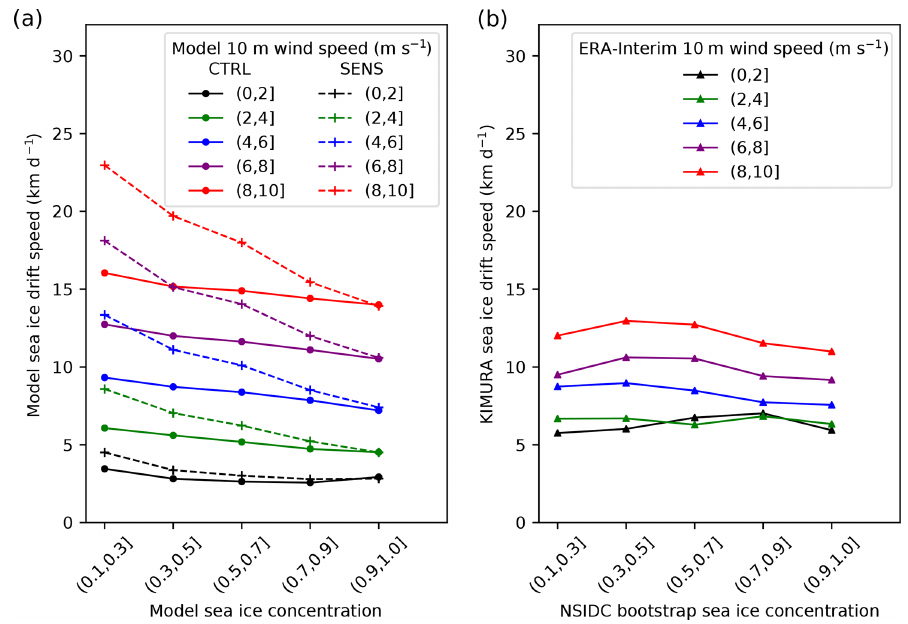
Figure 10. The (a) simulated relationship between sea ice drift speed and sea ice concentration for different near-surface wind speed classes (different colors) for the 2007 summer (JJAS) in the CTRL (circle marker and solid line) and SENS (cross marker and dashed line) experi- ment. The relationship based on KIMURA sea ice drift speed, NSIDC bootstrap sea ice concentration, and ERA-Interim 10m wind speed is shown in (b) . The points in the plot are the median value of all the daily data and on all grid points within the study domain indicated in Fig. 1 under certain wind speed and sea ice concentration classes. In the labels of different sea ice concentration and 10m wind speed classes, “(” means exclusive and “]” means